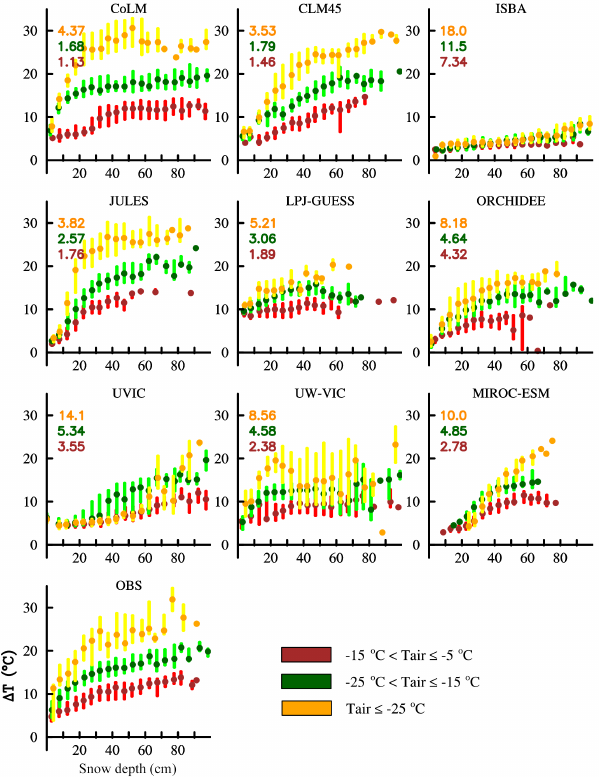
Figure 1. Variation of (cid:49)T ( ◦ C), the difference between soil tem- perature at 20cm depth and air temperature with snow depth (cm) for winter 1980–2000. The dots represent the medians of 5cm snow depth bins and the upper and lower bars indicate the 25th and 75th percentiles, calculated from all Russian station grid points ( n = 268) and 21 individual winters. The numbers in each model panel indi- cate the RMSE between the observed and modelled relationship. Colours represent different air temperature